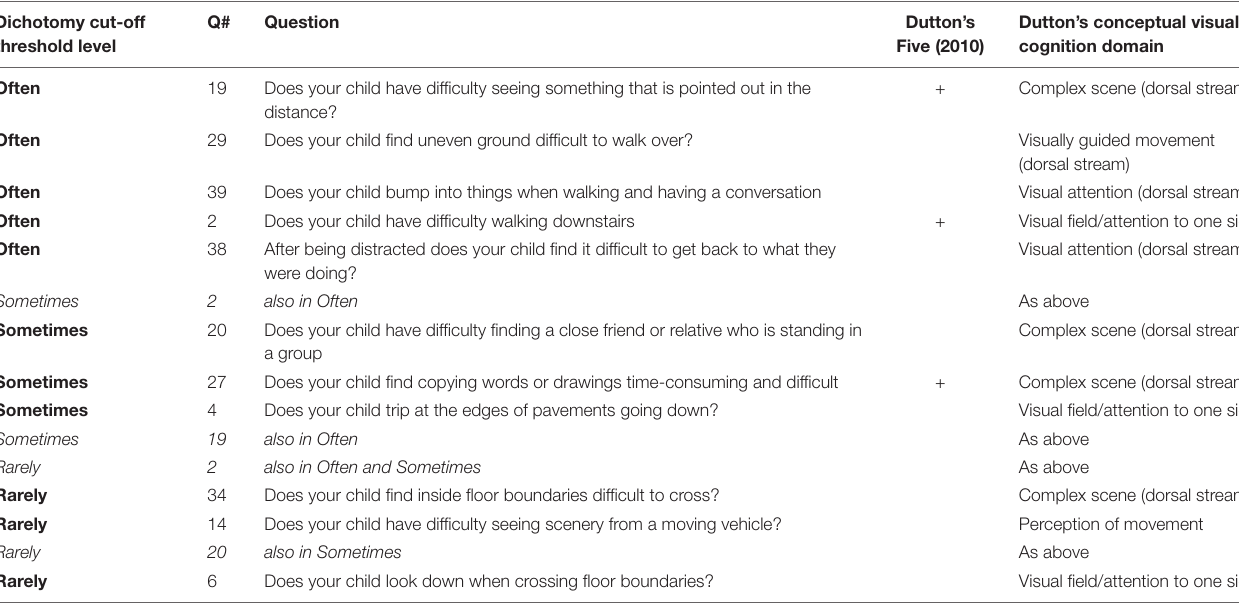
TABLE 4 | The Top-11 subset of the HVFQI-51.